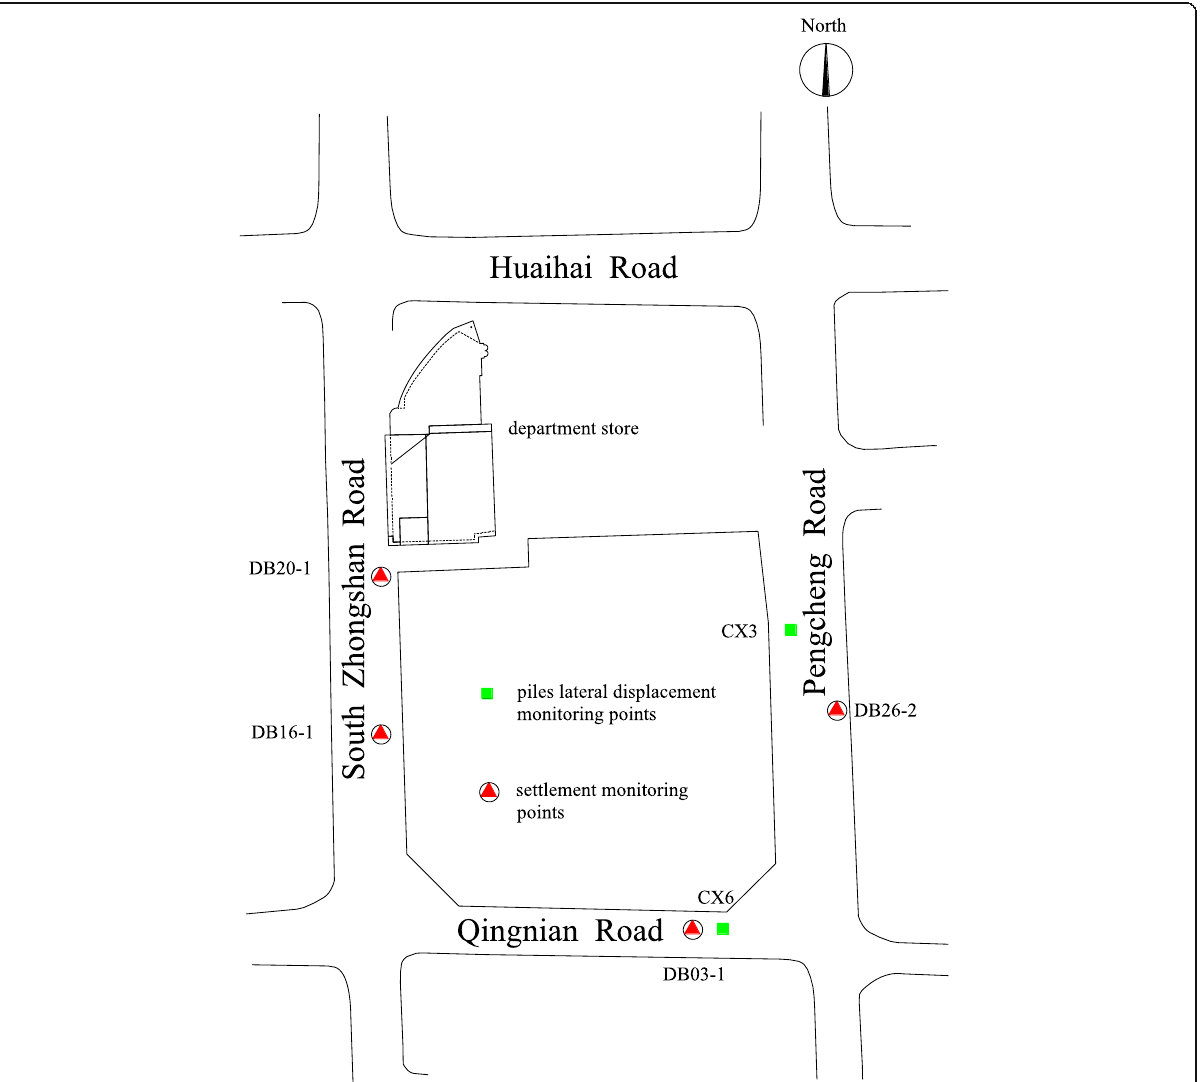
Fig. 1 Site Location and Layout of Monitoring Points. Through geotechnical investigation, the stratums of construction site are shown in Table 1